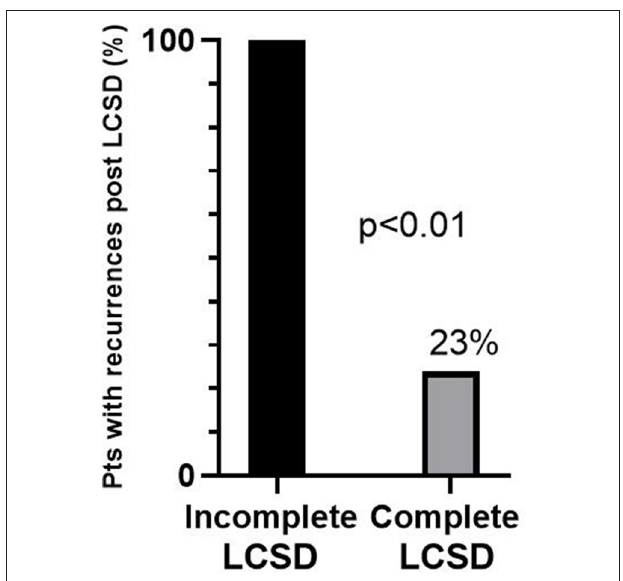
FIGURE 2 | Percentages of recurrences after left cardiac sympathetic denervation (LCSD) in 38 CPVT patients who had previously suffered major cardiac events despite optimal medical therapy. The majority received a complete LCSD ( n = 33), the remaining ( n = 5) an incomplete LCSD. Modified from De Ferrari et al. (129) with